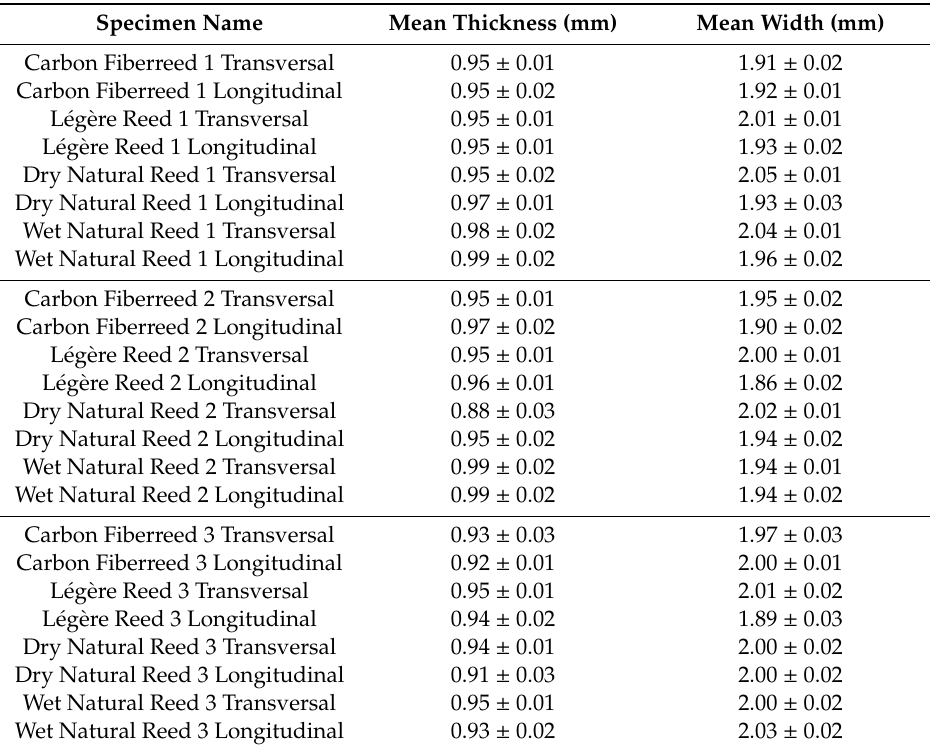
Table 1. Thickness and width of di ff erent